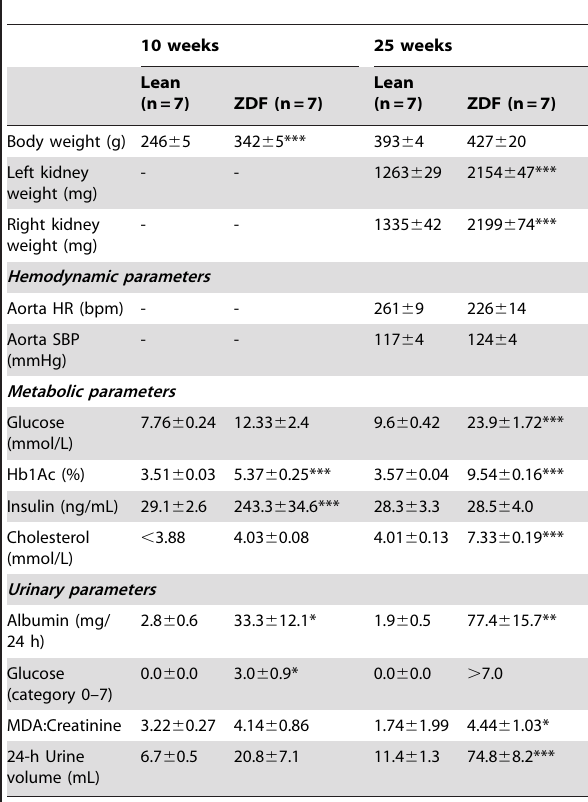
Table 1. Characteristics of ZDF and lean control rats at 10 and 25 weeks of